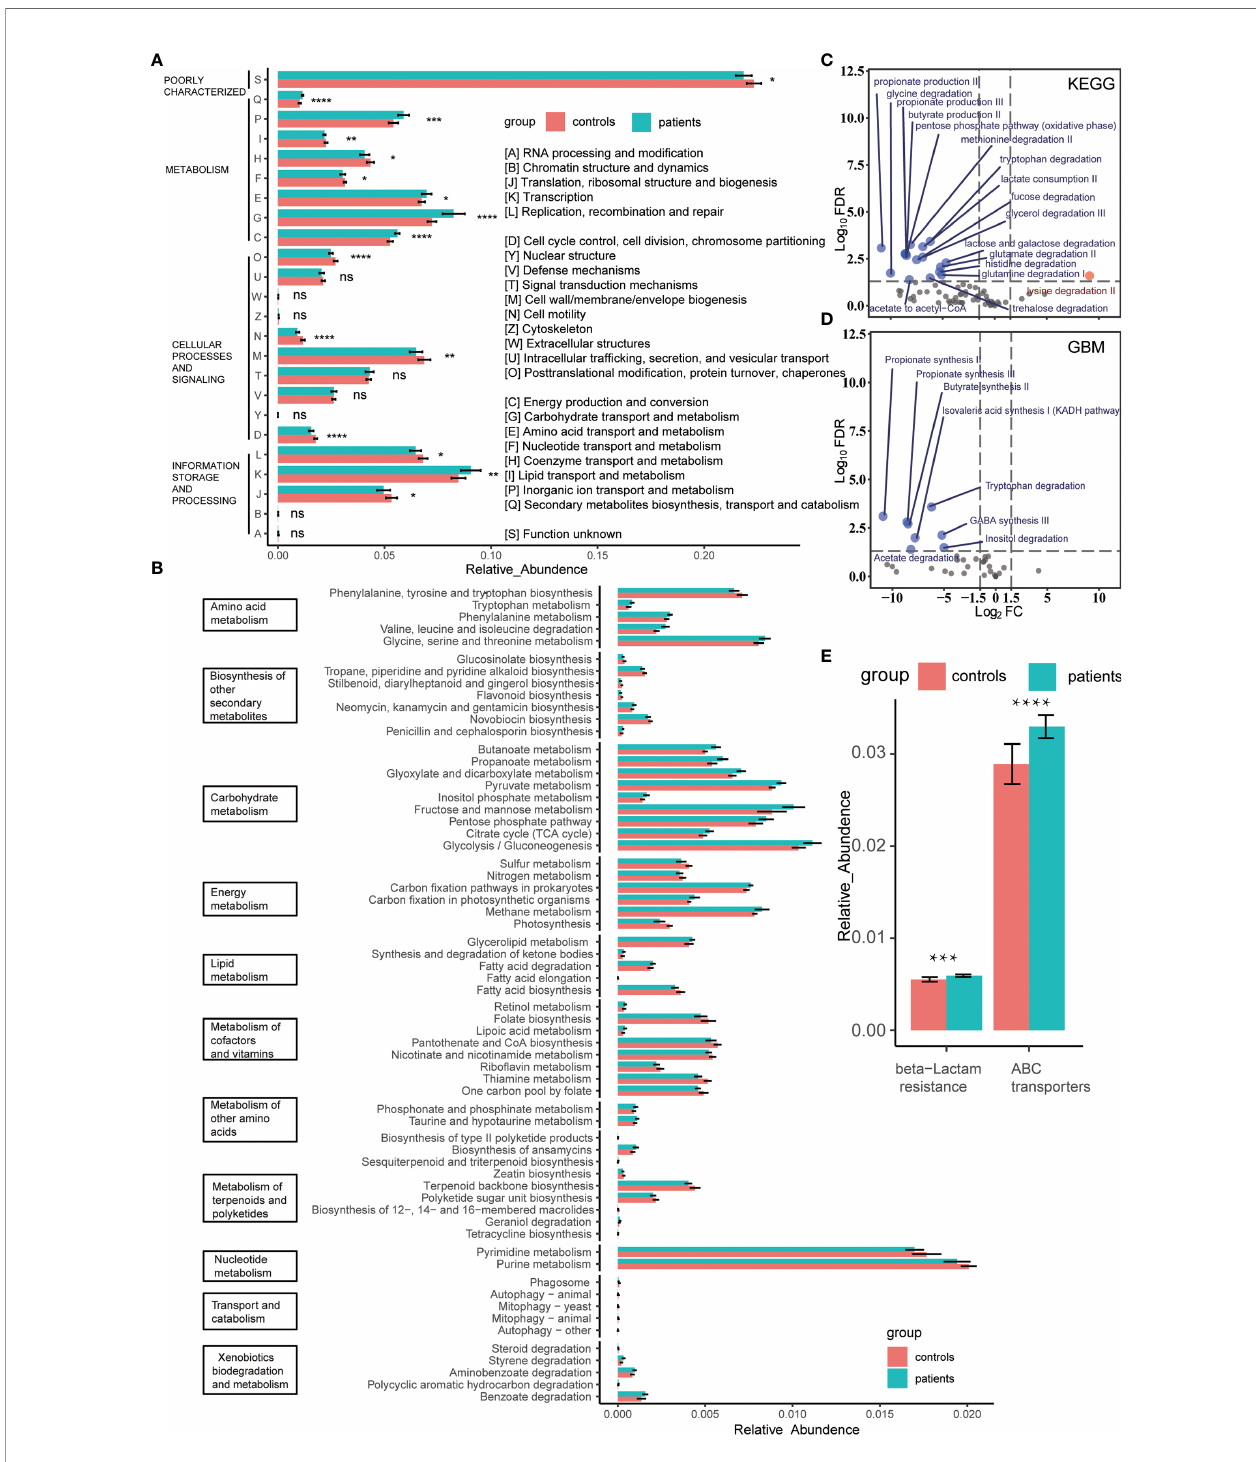
FIGURE 2 | (A) Comparison of proteins annotated by the COG database between groups. The relative abundance of protein orthologs in each catalog was compared by the Wilcoxon rank-sum test. * means FDR < 0.05, ** means FDR < 0.01, *** means FDR < 0.001, **** means FDR < 0.0001. (B) Bacterial metabolic activity comparison between groups based on the relative abundance of protein orthologs annotated by the KEGG database. All FDRs of metabolic pathways were < 0.05. (C, D) . Volcano plot of the KEGG modules or the GBM modules enriched by KEGG protein orthologs, modules with FDR < 0.05 and |log2FC| > 1.5 were identi fi ed as the differential modules. The blue and red represent the patient group and controls, respectively. (E) Comparison of antibiotic resistance-related pathways between patients and controls. The relative abundance of protein orthologs that participated in the pathways was compared